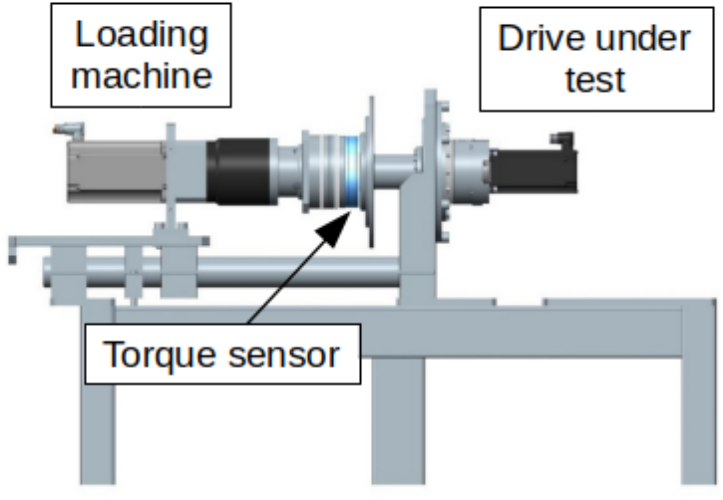
Figure 1. Experimental setup for the measurements and